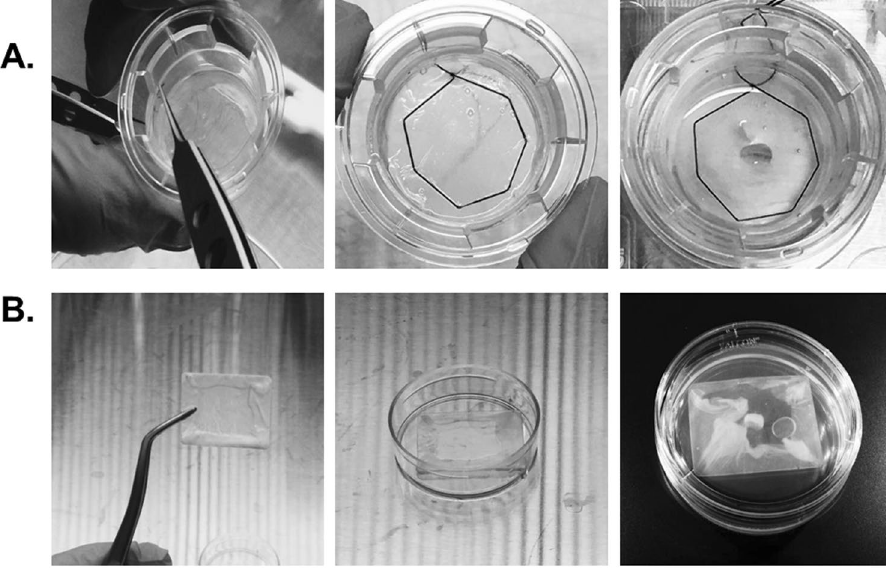
Figure 6. Construction of HAMTW and HAMS. ( A ) HAMTW. HAM was fitted on TW insert and the edge was sutured at 6 points with black silk 6/0 thread in order to form a physical seal and to secure the explant. ( B ) HAMS. Constructed glass slide is enveloped with HAM that is tucked into culture